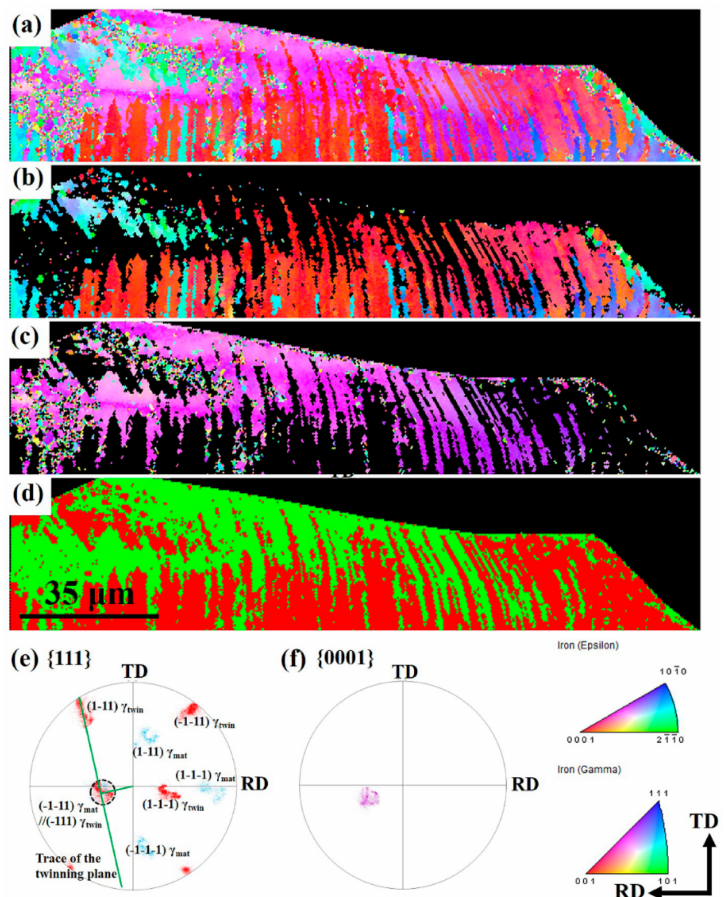
Figure 9. Microstructure of tensile deformed specimen after 35% warm rolling reduction, taking at Grain 2: ( a ) The RD orientation maps for all data, ( b ) the FCC structures, ( c ) HCP structures, ( d ) phase map, ( e ) {111} pole figure and ( f ) {0001} pole